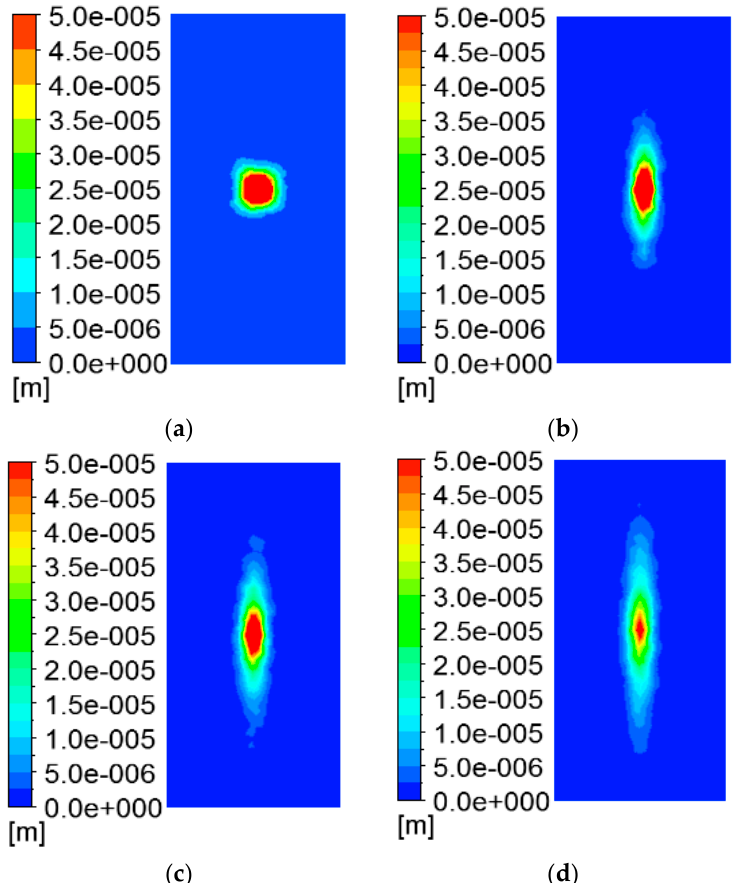
Figure 7. Coating film thickness distribution contours for four shaping air pressures: ( a ) 0 MPa; ( b ) 0.02 MPa; ( c ) 0.05 MPa; ( d ) 0.07 MPa.